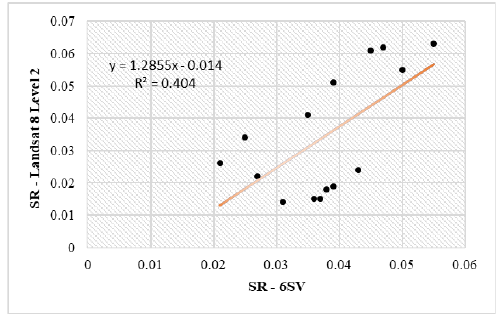
Fig. 5 Surface reflectance linear regression in coastal aerosol band 6SV atmospheric correction in Landsat-8 band 4 also retrieved SR-product which was compared to Landsat-8 Level 2 SR product (Fig.4). Atmospheric correction for OLI band 4 gives RMSE of 0.013 which means that the results have